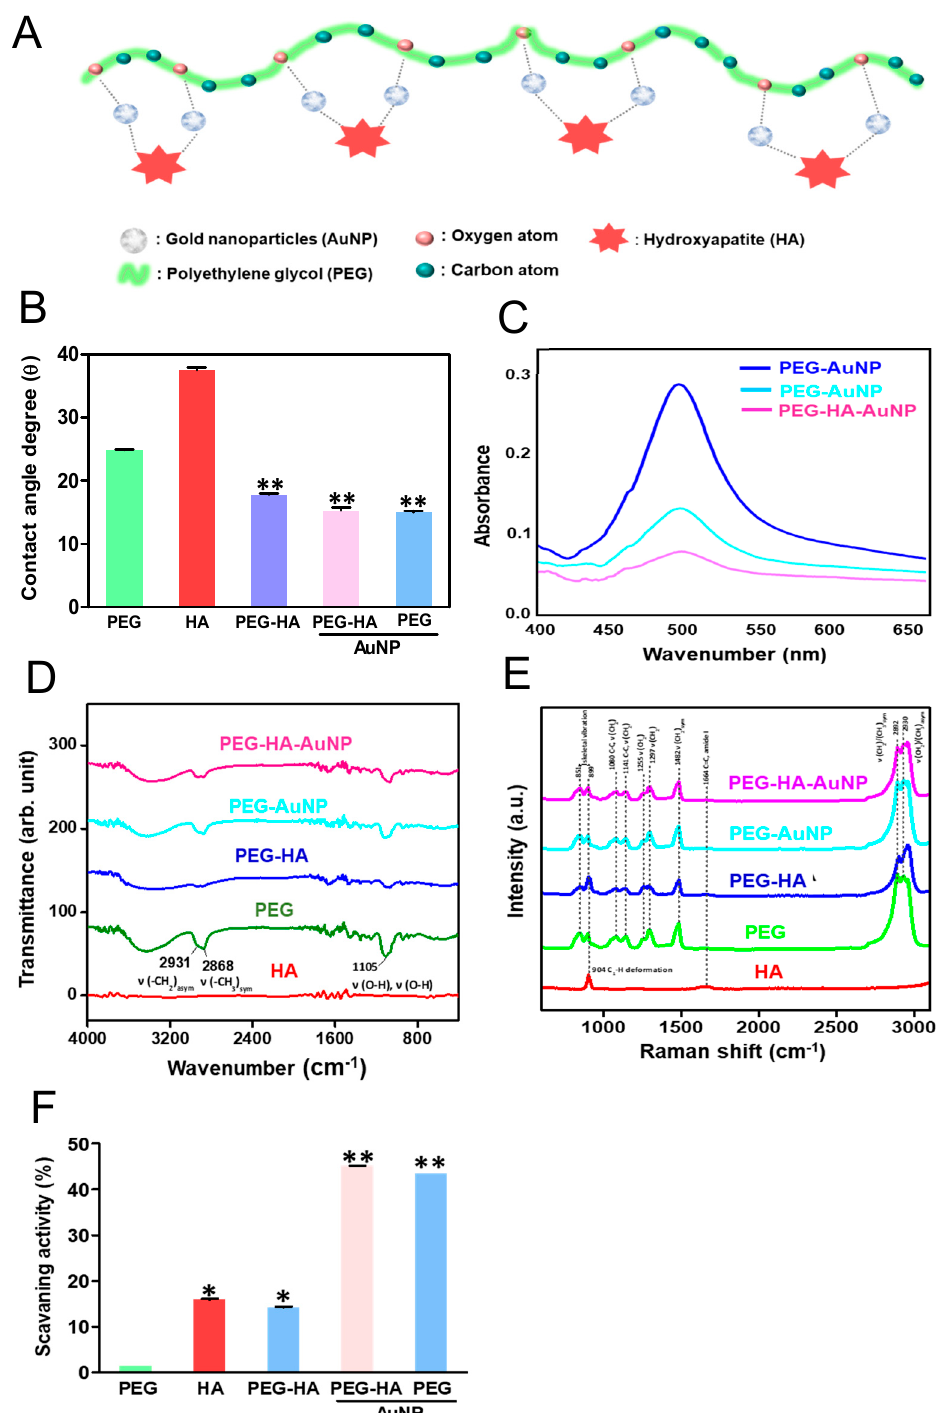
Figure 1. ( A ) Schematic diagram illustrating the preparation procedure of PEG-HA-AuNPs. Characterization of PEG-HA-AuNP nanocomposites: ( B ) Average contact angle ( θ ) quantified from different materials. The contact angle from different materials without water is θ = 0 ◦ . Data are the mean ± SD ( n = 3), ** p < 0.01, smaller than the control treatment (PEG). ( C ) UV–Vis spectra, ( D ) FTIR spectra, and ( E ) Raman spectra of different materials. ( F ) Free radical scavenging effect of HA, PEG, and PEG nanocomposites. Free radical scavenging effect of HA, PEG, and PEG nanocomposites. Mean ± SD. * p < 0.05; ** p < 0.01: greater than control.